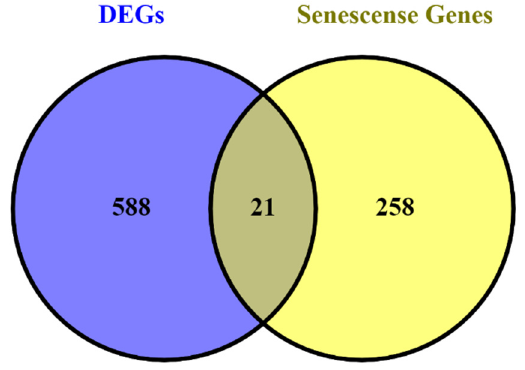
Figure 14. A total of 21 DEGs are related to cell senescence.